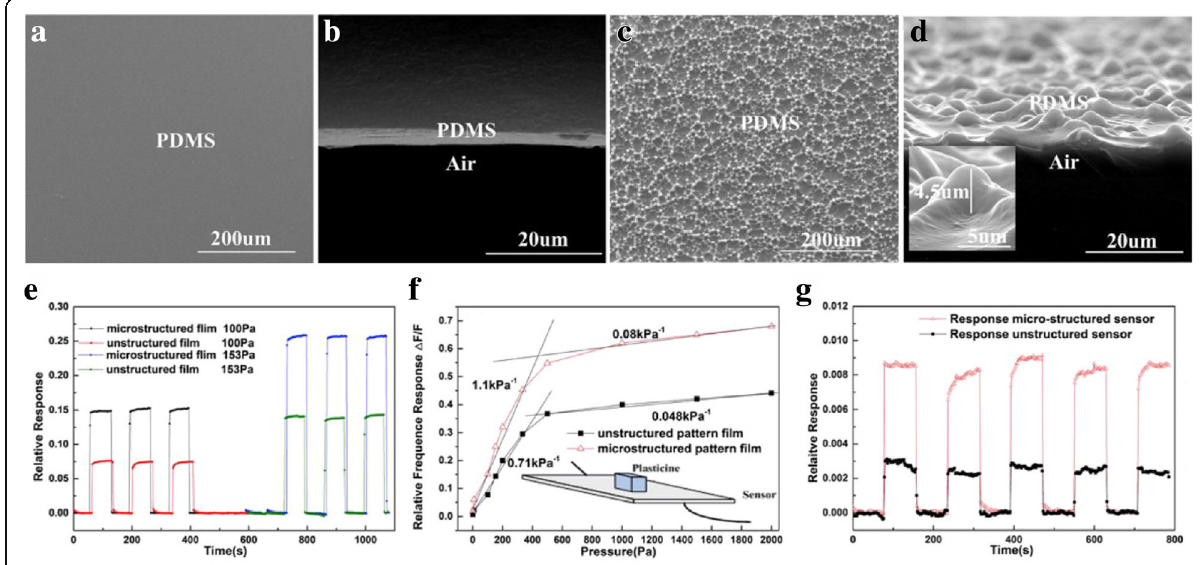
Fig. 4 a – d SEM image of top view ( a ) and side view ( b ) of unstructured PDMS film, SEM image of top view ( c ), and side view ( d ) of microstructured PDMS film. e Comparison of the relative responses of the sensors with different structures. f Sensitivity testing of the two structured sensors. g The response of the two structured sensors under 1 Pa pressure. Adapted with permission from ref. 18.